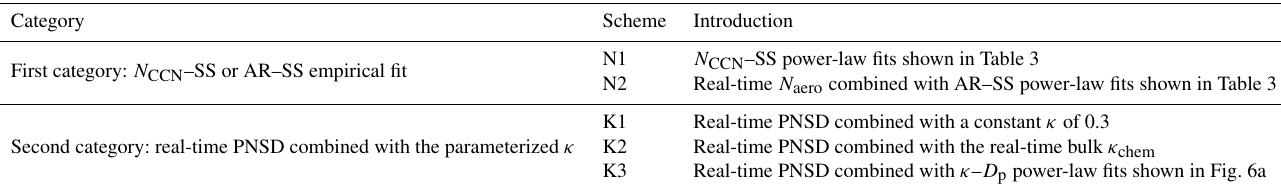
Table 3. Introduction of five activation schemes. The meaning of the abbreviations can be found in Appendix A.